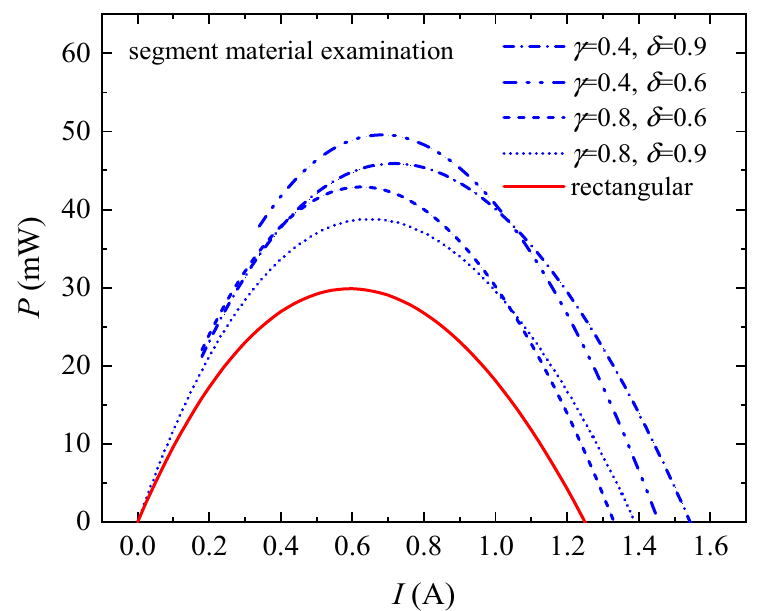
Figure 4. Unit power as a function of current with various segmented designs compared with the uniform material structure.